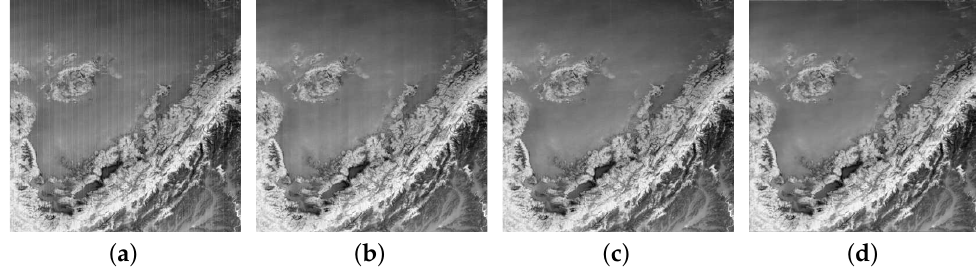
Figure 1. Image component of destriping results in Terra MODIS band 33: ( a ) original image; ( b ) WAFT; ( c ) SLD; and ( d )